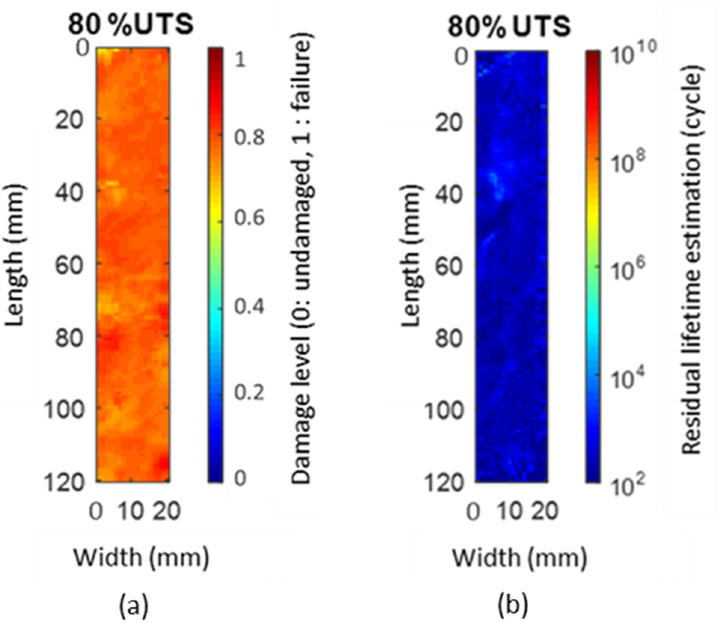
Figure 12. ( a ) Damage level and ( b ) residual lifetime estimated by neural network algorithm. Adapted from [21].